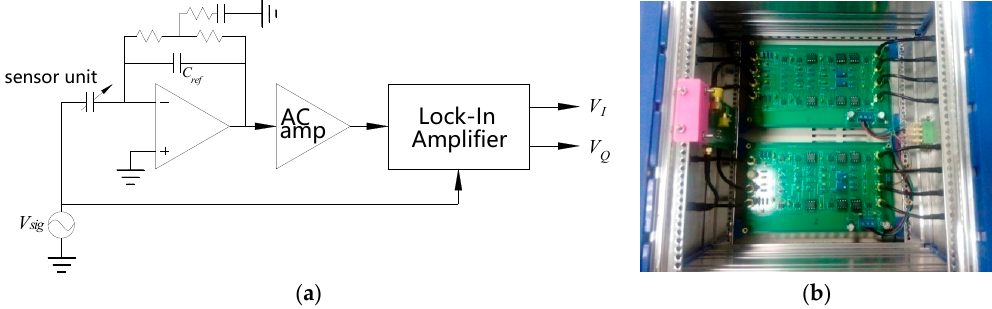
Figure 21. The signal processing circuit of the sensor: ( a ) Block diagram of the principle; ( b ) photograph.